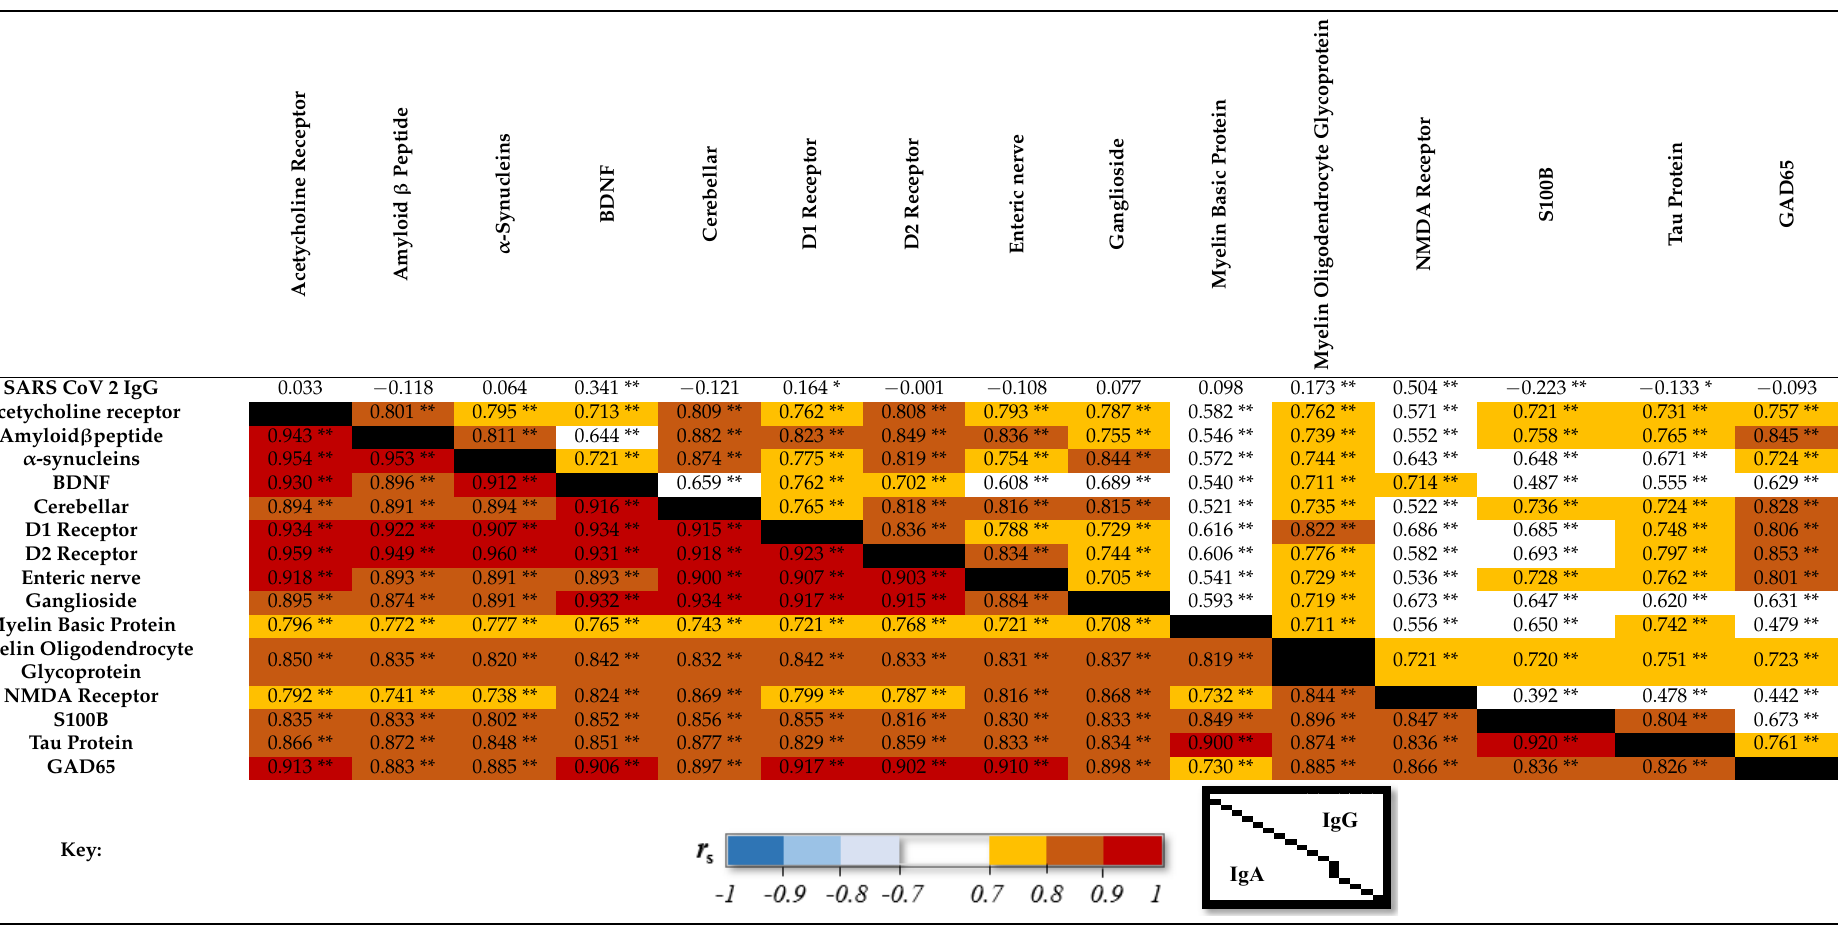
Table 2. Correlation Between Antibody Levels. Spearman’s rho correlation coefficients showed very strong correlations between all IgA antibody levels. * Correlation is significant at the 0.05 level (2-tailed). ** Correlation is significant at the 0.01 level